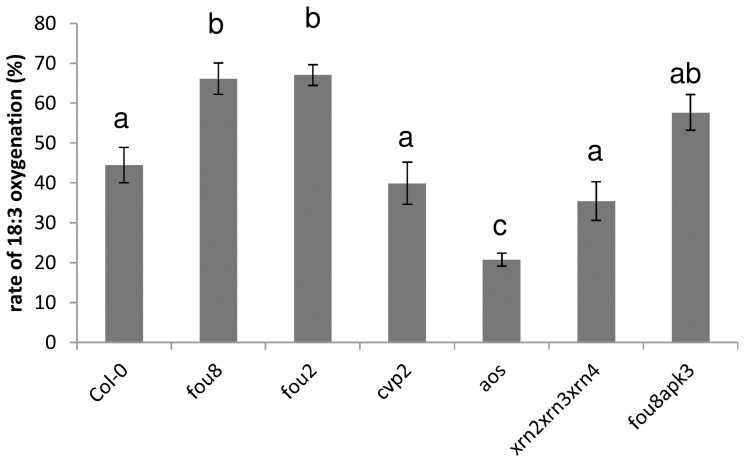
Variation in fatty acid oxygenation rate in fou8 related genotypes.The various Arabidopsis lines were grown for 5 weeks in controlled environment room. Leaf juice was incubated for 2 min with 1-[14C]18∶3. Products were separated by thin layer chromatography and the radioactivity quantified. The rate of oxygenation is expressed as % of radioactivity in 18∶3-α-ketol. Results are presented as means ± SE from six individual plants grown in two independent experiments, different letters mark values significantly different at P<0.05.